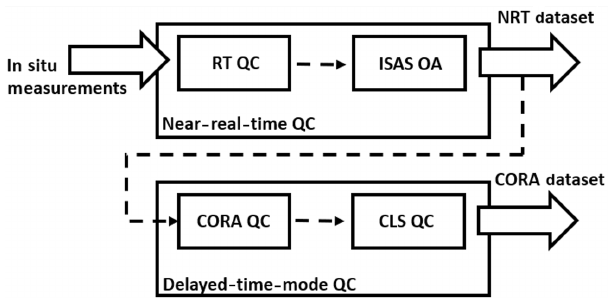
Figure 4. Coriolis database validation